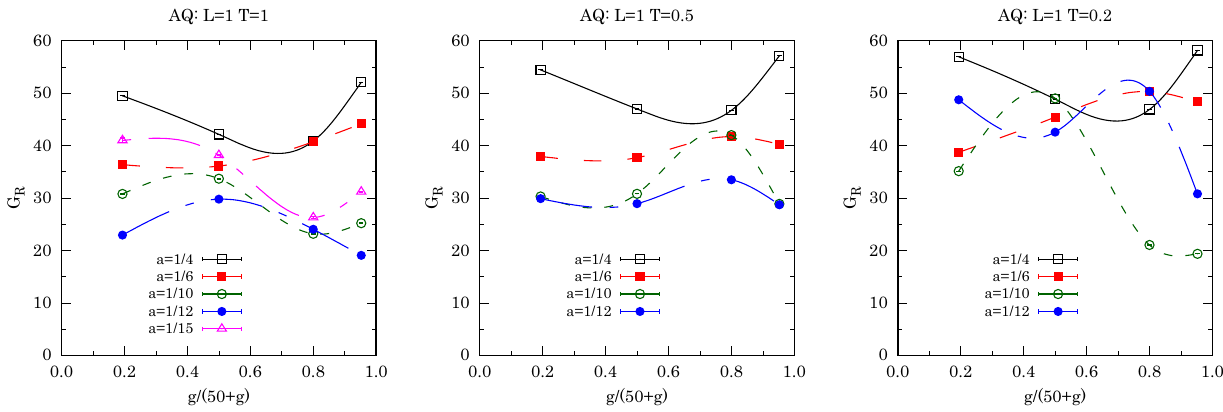
Fig. 1 The left panel is for AQ with L = 1 and T = 1, The cen- tral panel is for AQ with L = 1 and T = 0 . 5, and the right panel is for AQ with L = 1 and T = 0 . 2. We show the renormalized cou- pling constant G R , defined in the text, as a function of g /( 50 + g ) for decreasing values of the lattice spacing a . The renormalized mass was kept fixed to m R ≈ 3 (within 10%) in all cases. The statistical errors